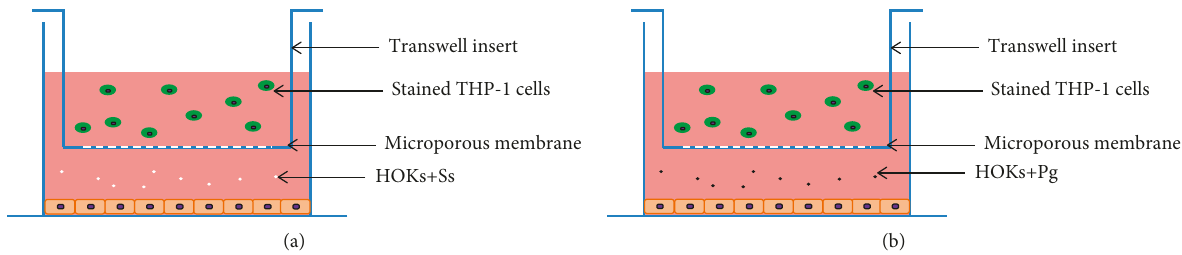
Figure 1: The models for chemotactic effect transwell apparatus. (a) HOKs challenged by commensal S . sanguinis (Ss); (b) HOKs challenged by periodontopathogen P . gingivalis